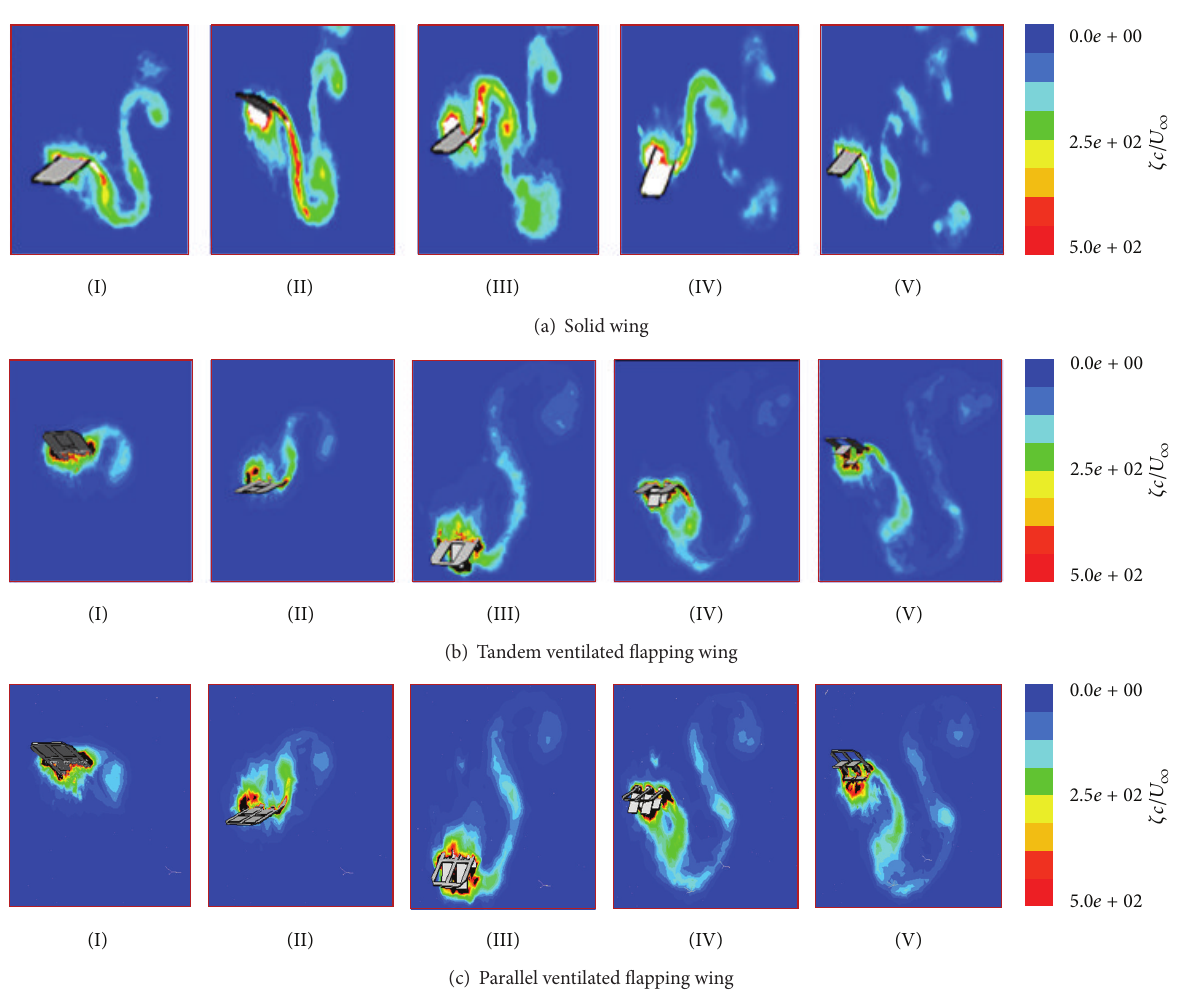
Figure 8: Contours of normalized vorticity magnitude 𝜁𝑐/𝑈 at different time and at zero angle of attack (AOA).